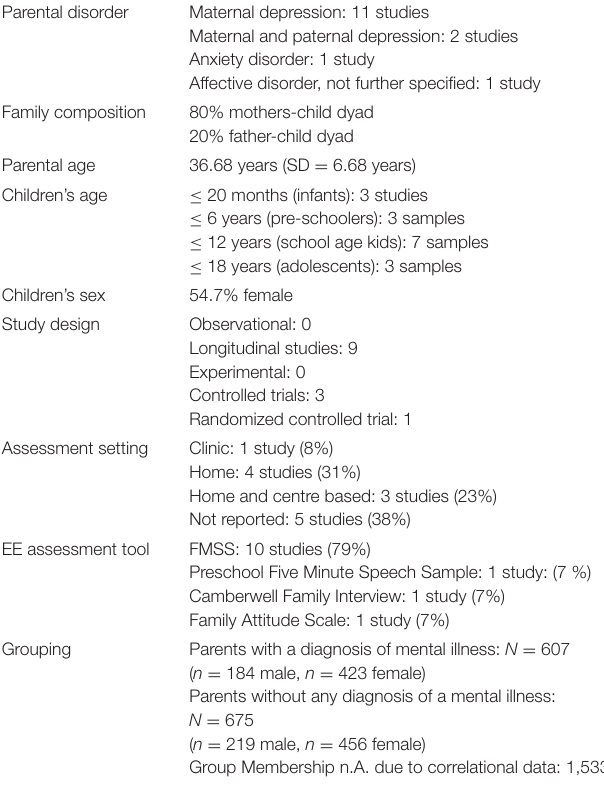
TABLE 1 | Characteristics of parental psychopathology and EE studies with means, SDs, percentages. Parental disorder Maternal depression: 11 studies Maternal and paternal depression: 2 studies Anxiety disorder: 1 study Affective disorder, not further specified: 1